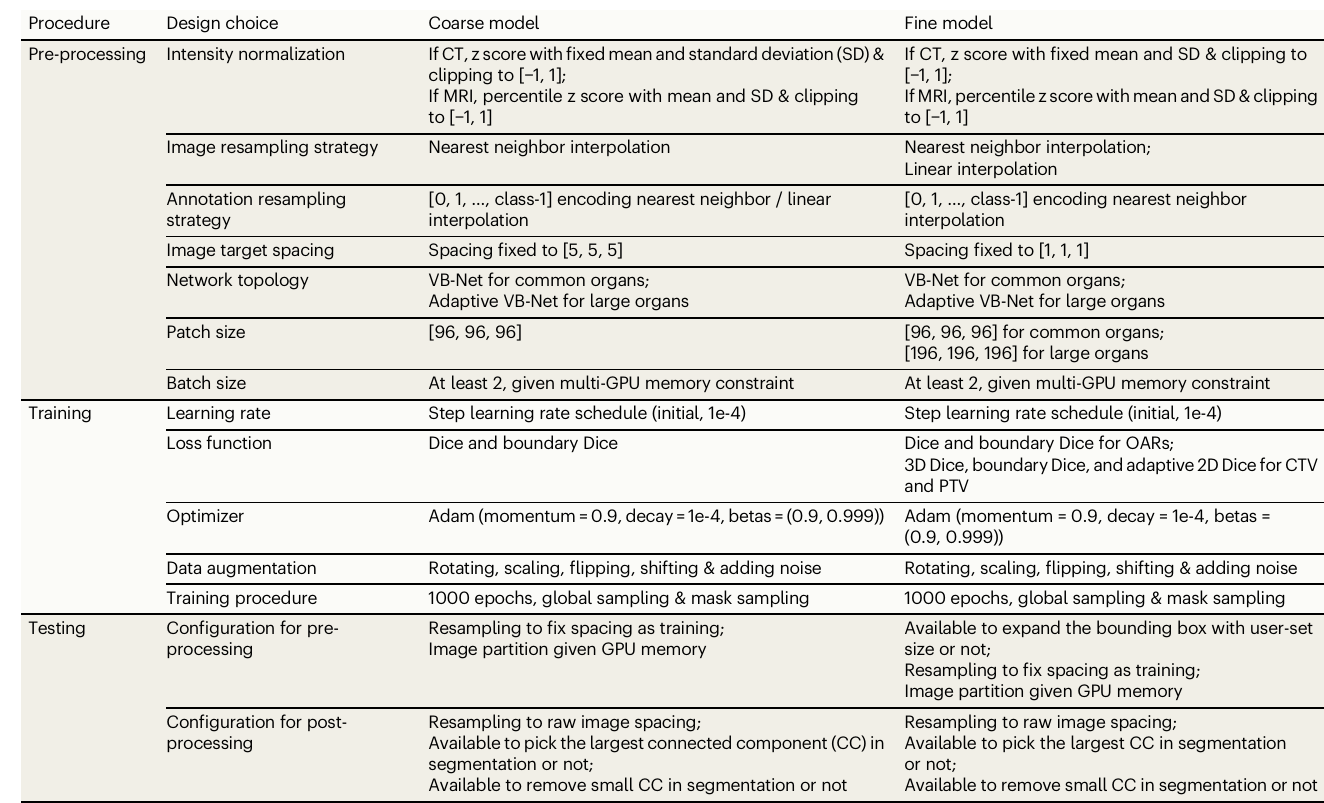
Table 1 | The detailed con fi guration for multi-resolution segmentation framework Procedure Design choice Coarse model Fine model Pre-processing Intensity